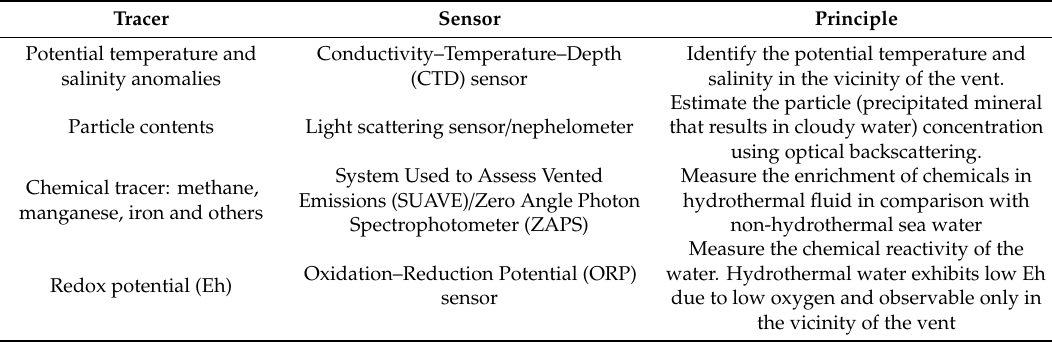
Table 7. Physical and chemical signatures (tracers) and their corresponding sensors. Tracer Sensor